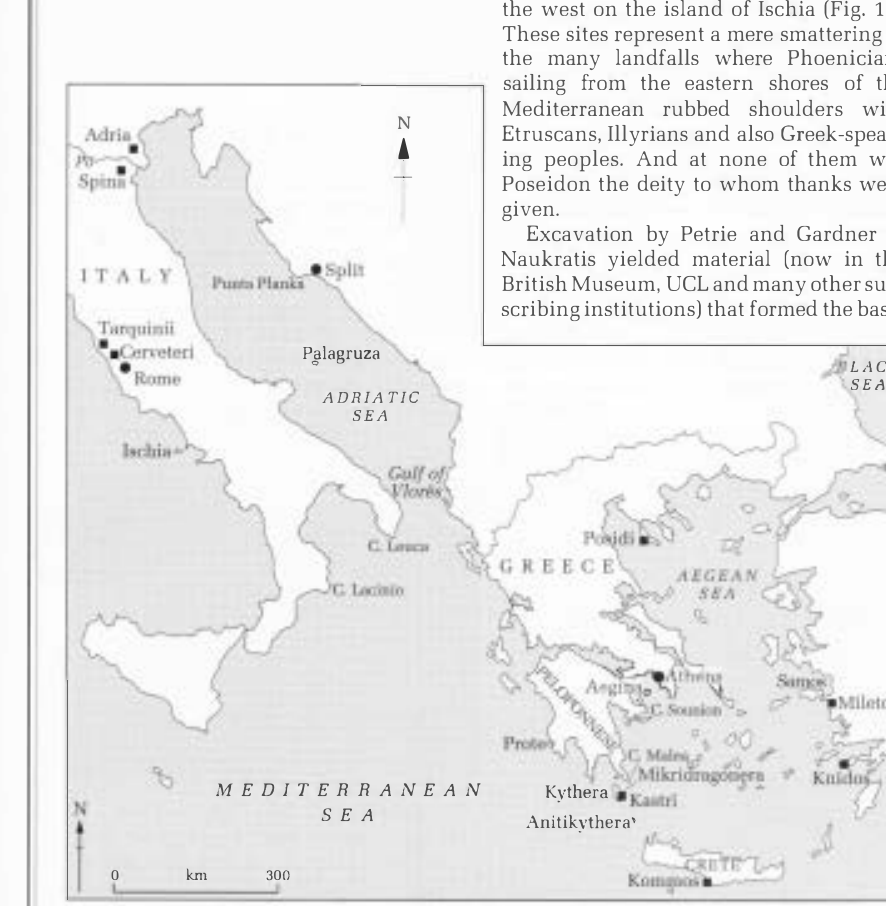
Figure 1 The eastern Mediterranean showing the location in the area of geographical features and ancient sites mentioned in the